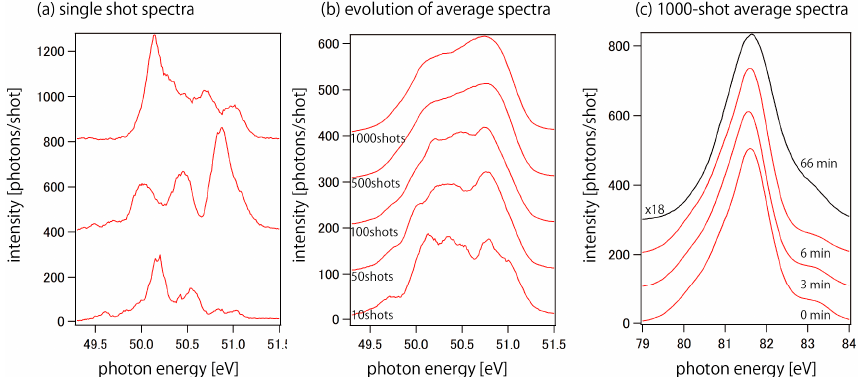
Figure 2. Typical ( a ) single-shot spectra, ( b ) the evolution of the spectrum as a function of the number of averaging, and ( c ) 1000-shot average spectra of incident free-electron laser (FEL) pulses.